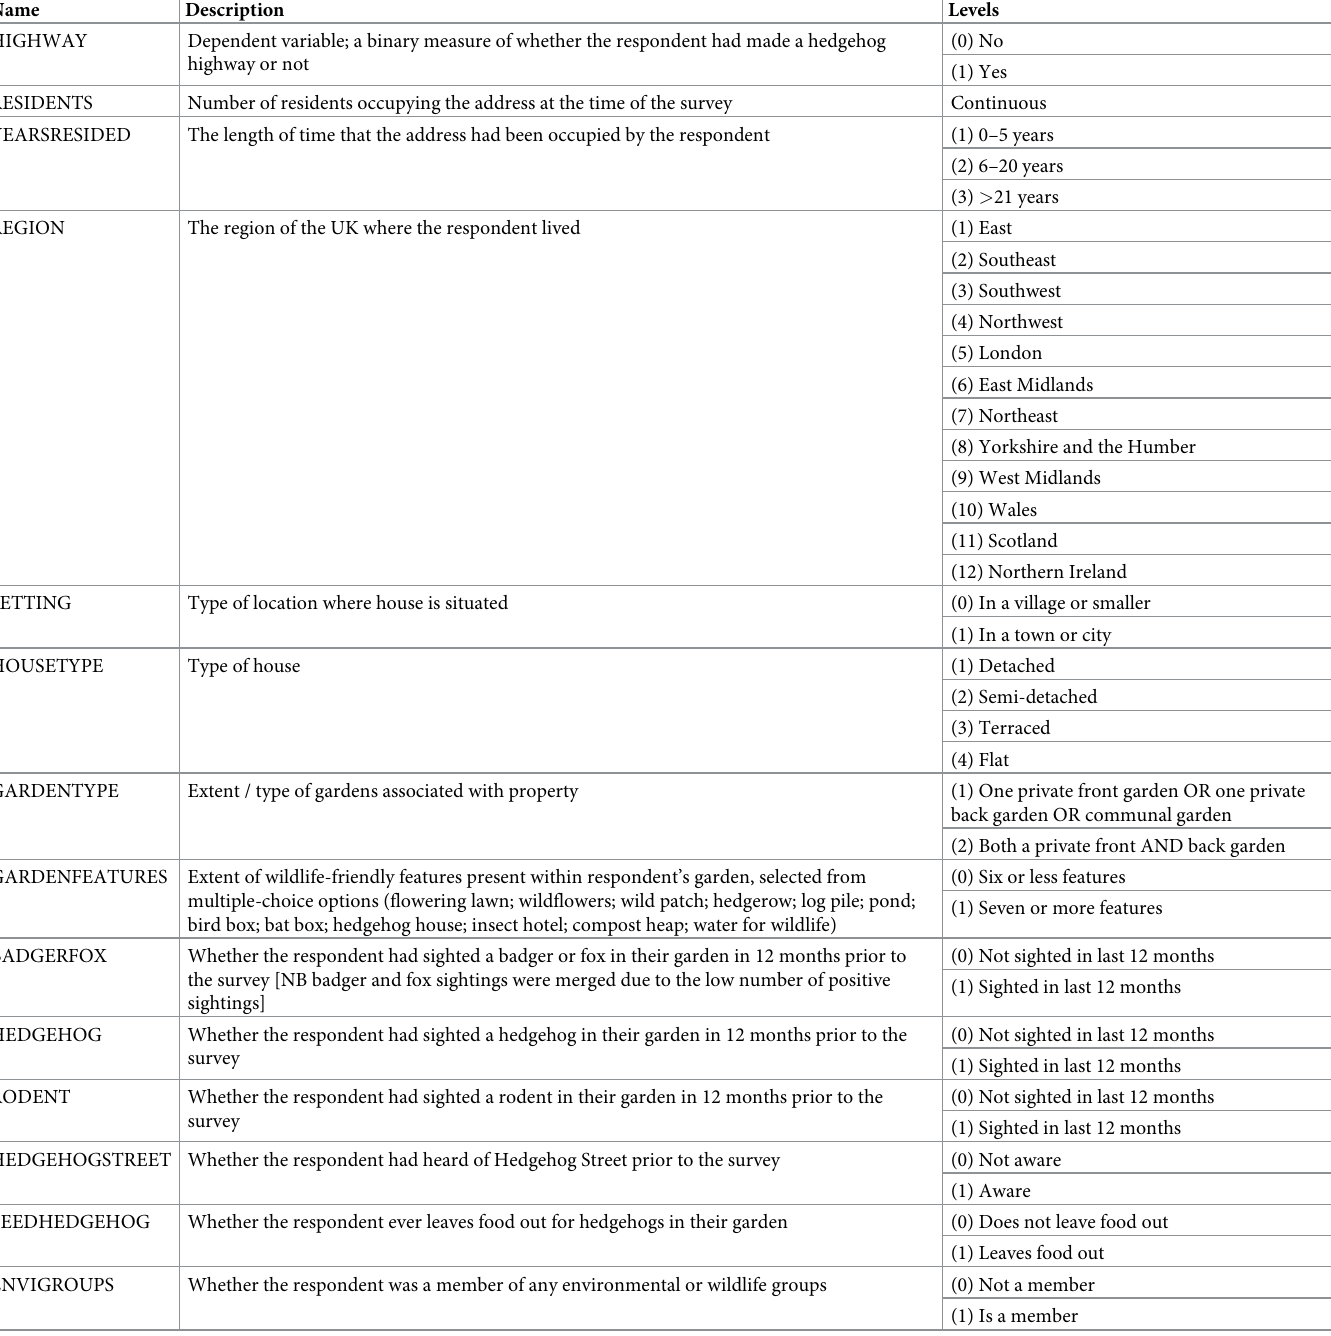
Table 1. Summary of variables requested in the 2018, 2019 and 2020 surveys that were used to investigate the factors affecting a householder’s decision to create a hedgehog